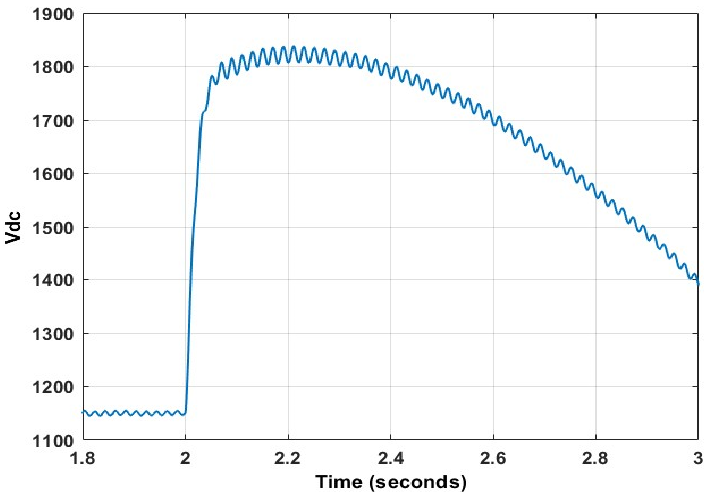
Figure 34. DC voltage transient using PI at 80% dip.